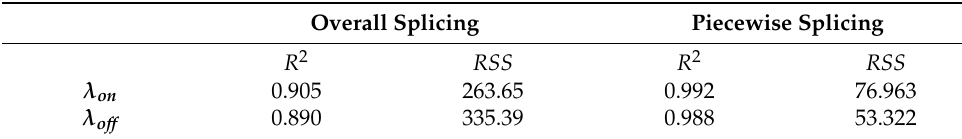
Table 1. Evaluation parameters of spliced signal.